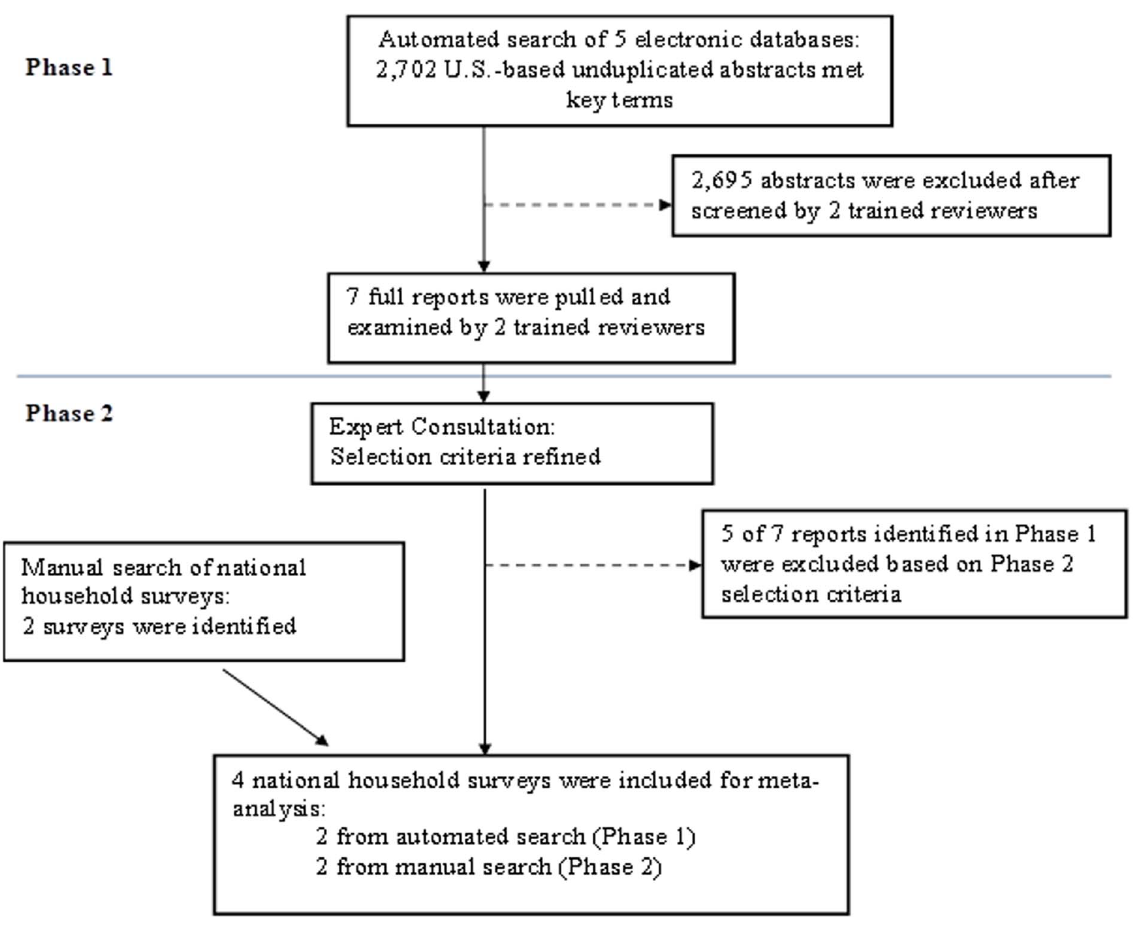
Figure 1. Survey Selection Flowchart for Meta-Analysis.